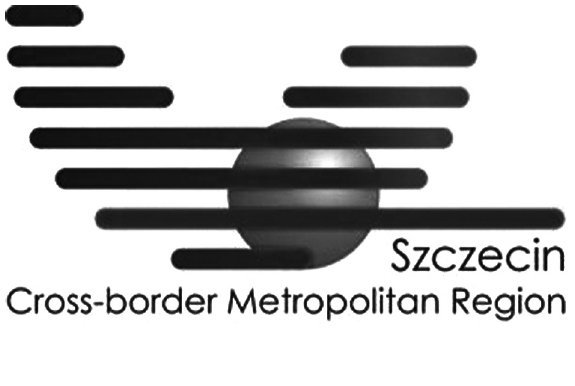
Fig. 4. logo of the Szczecin Cross-Border Metropolitan re - gion (in the original coloured version with green and blue stripes and a red circle). Source: http://gl.berlin-brandenburg.de/europ-raumentwicklung/